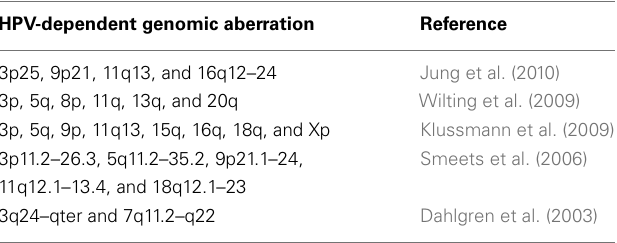
Table 1 |Alteration in the genome of HNSCCs: genomic aberrations characteristic for HPV-related